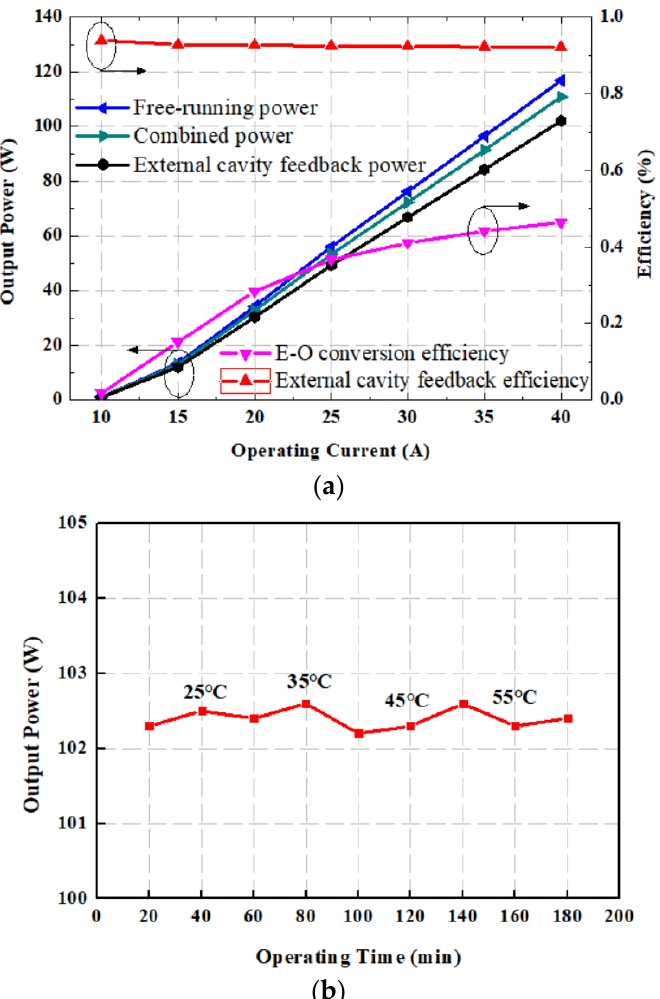
Figure 6. ( a ) Output power and external cavity feedback efficiency as a function of operating current; ( b ) output power with operating time at different temperature tuning range.